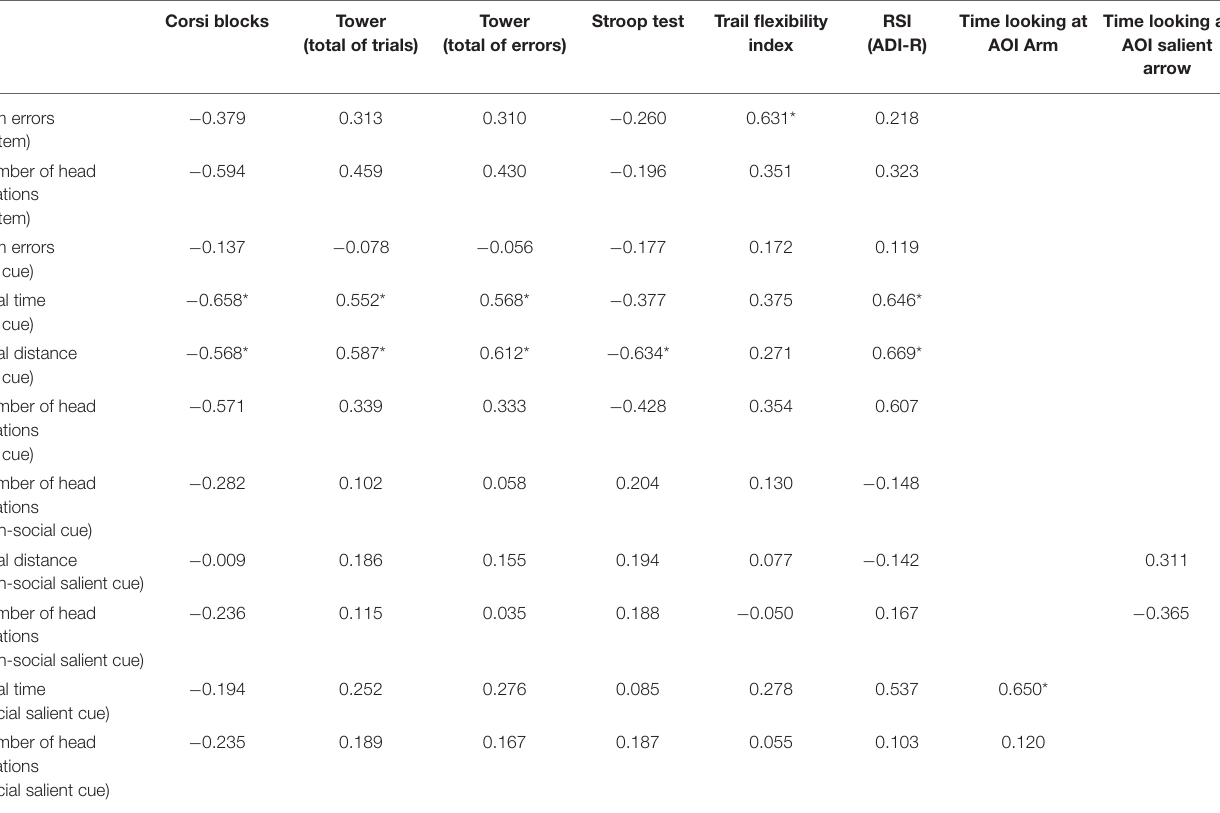
TABLE 2 | Spearman’s rank correlation coefficients between the EcosupermarketX behavioral parameters, neuropsychological tests, ASD core social interaction features, and eye-tracking measures in the ASD group. Corsi blocks Tower (total of